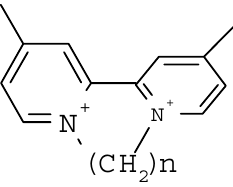
Figure 1. DBPA structures (the torsional angle formed by the N,N’-alkylidene